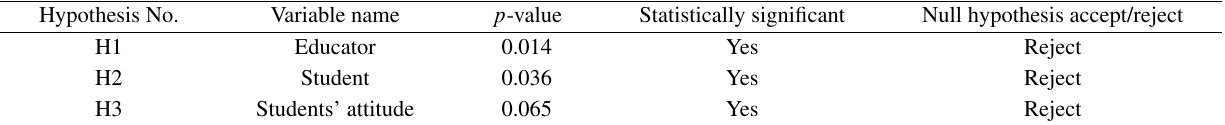
Table 7 Hypotheses testing.